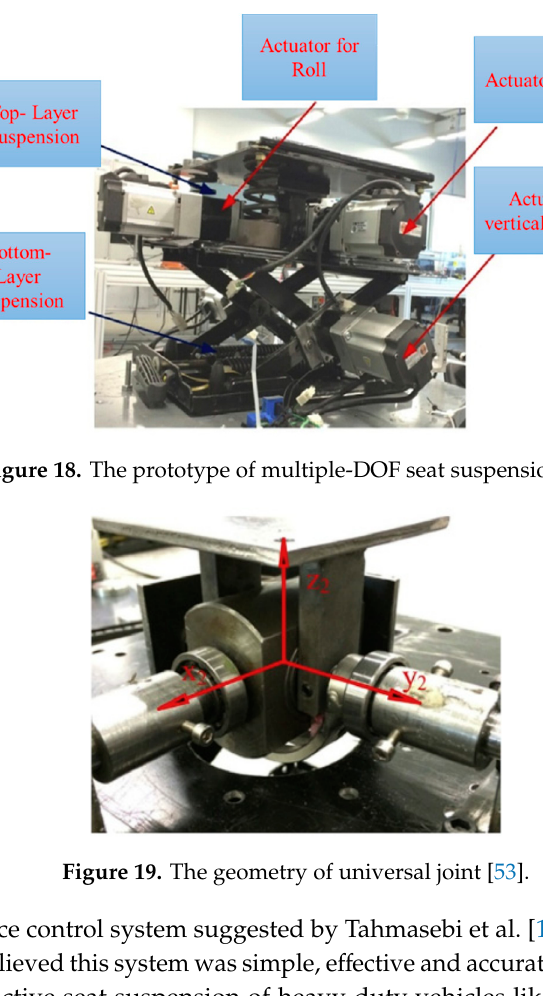
Figure 19. The geometry of universal joint [53].